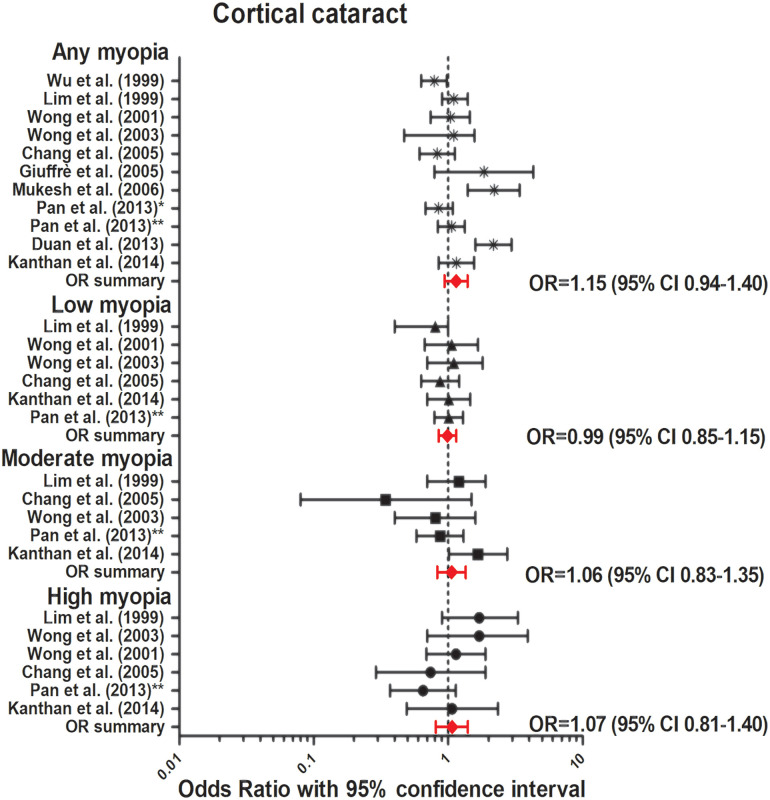
Forest plot of cortical cataract in any myopia (random effects model; Q = 11.5; I2 = 12.8); low myopia (fixed effects model; Q = 0.9; I2 = 0.0); moderate myopia (fixed effects model; Q = 7.15; I2 = 30.1); and high myopia (fixed effects model; Q = 6.7; I2 = 25.9). Red lines with diamond represents the summary OR per myopia category, which are as follows: any myopia OR, 1.15 (95% CI, 0.94–1.40); low myopia OR, 0.99 (95% CI, 0.85–1.15); moderate myopia OR, 1.06 (95% CI, 0.83–1.35); and high myopia OR, 1.07 (95% CI, 0.81–1.40). *Represents Pan et al.60 2013 Singapore Malay Eye Study. **Represents Pan et al.61 2013 Singapore Indian Eye Study.